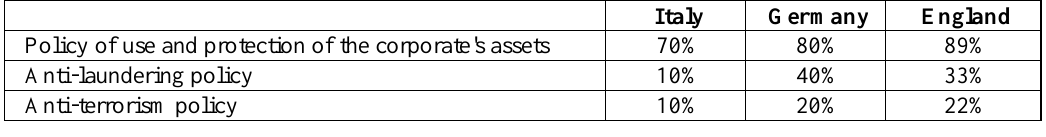
Table 12: Other Standard Behaviour Policy of use and protection of the corporate's